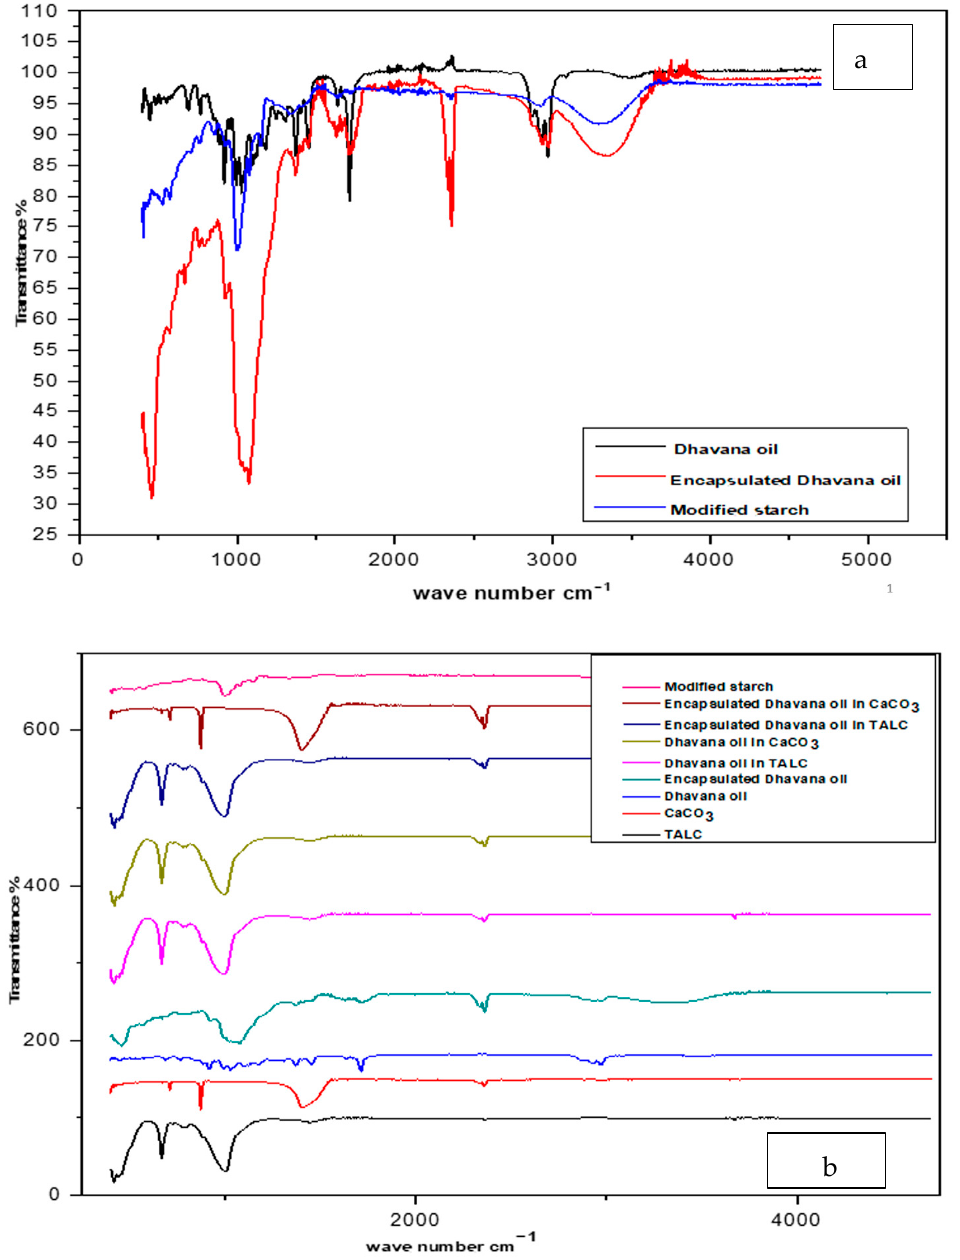
Figure 5. ( a , b ): FTIR analysis of neat and encapsulated Dhavana oil, Modified starch, TALC, CaCO 3.